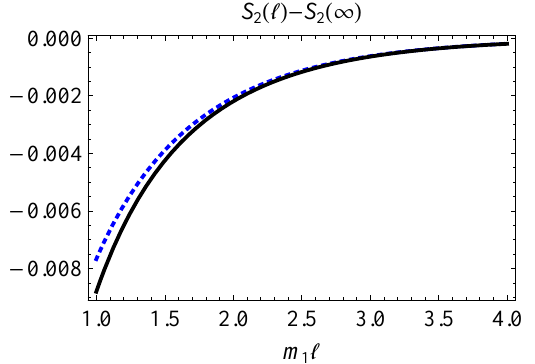
Figure 5: The function (51) (solid curve). The dashed curve is the contribution − 0.0182441 K ( m (cid:96) ) , that is the leading contribution to (51). Clearly the contribution pro- 0 1